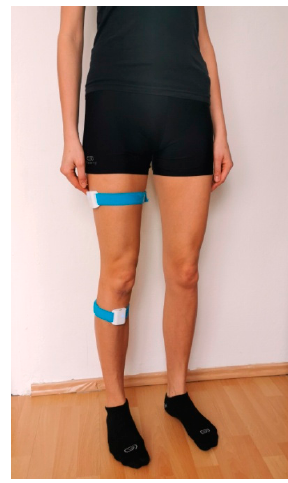
Figure 1. Placement of Orthyo ® system sensors on the lower extremity.